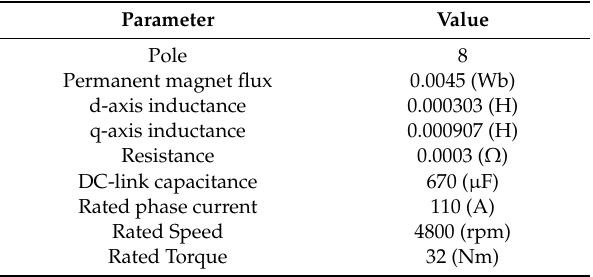
Table 1. PMSM drive